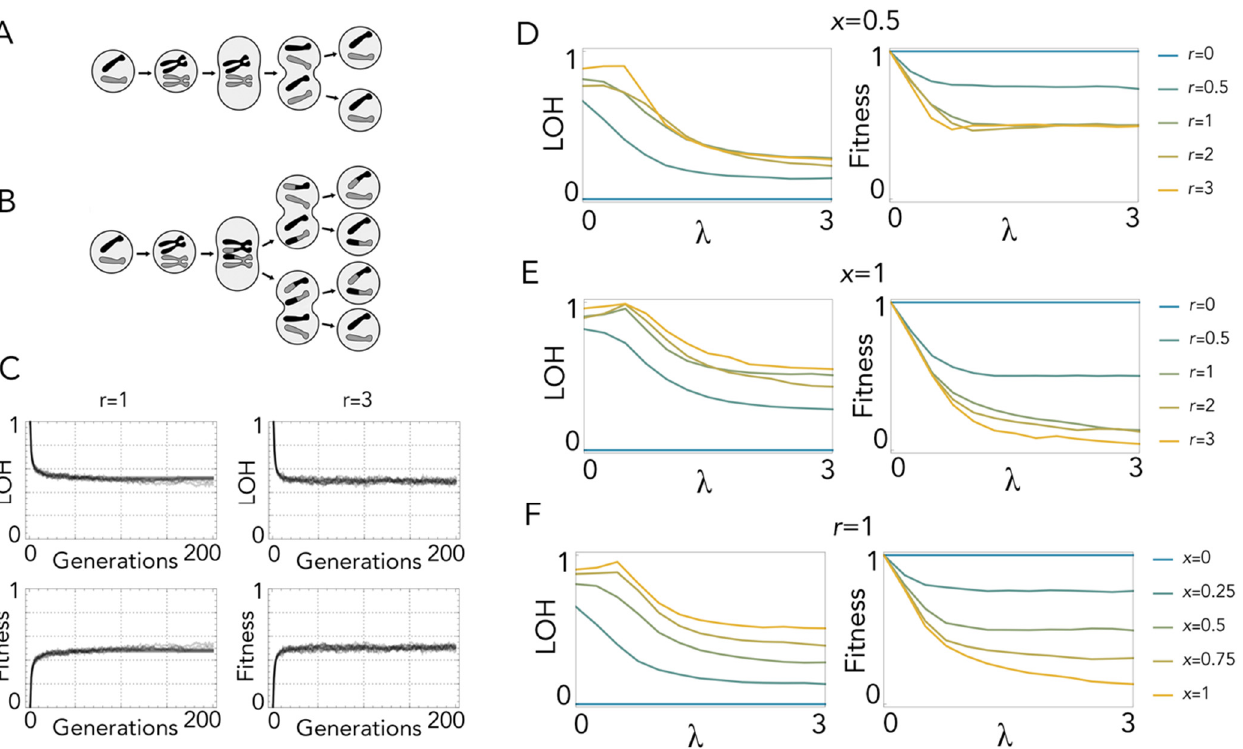
Figure 2. Loss of heterozygosity in mitosis. ( A ): Mitosis without recombination: there is no LOH. ( B) : Mitosis with one crossing-over event: daughter cells produced by x segregation have LOH. ( C ): Values of LOH and fitness over 200 generations with one lethal equivalent ( λ = 1) and one ( r = 1) or three ( r = 3) crossing-over events with random segregation (probability of x segregation x = 0.5). ( D ): LOH and fitness at equilibrium as a function of λ (the number of lethal equivalents) for different values of r (number of crossing-over events per replication) with x segregation occurring with the same probability ( x = 0.5) as z segregation. ( E ): LOH and fitness at equilibrium as a function of λ for different values of r with x segregation only ( x = 1). ( F ): LOH and fitness at equilibrium as a function of λ for different values of x with one crossing-over event ( r = 1).